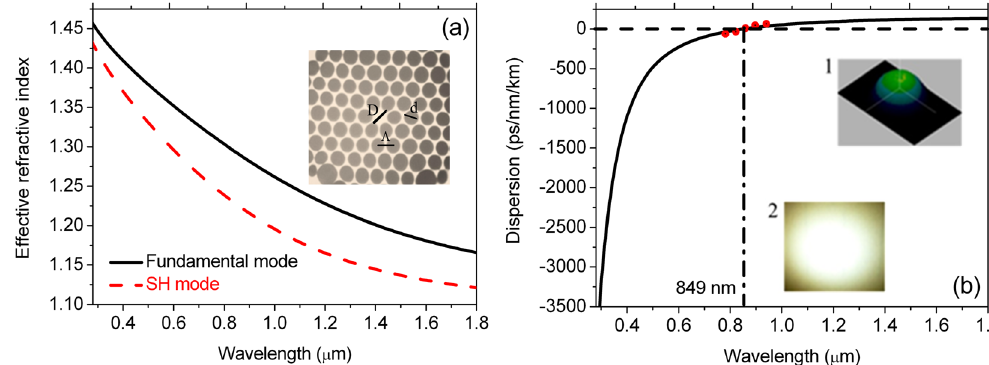
Figure 1. ( a ) The effective refractive index curves of the fundamental and SH modes calculated as functions of the wavelength. The inset shows the cross-sectional structure of the PCF used. ( b ) The calculated group-velocity dispersion profile of the fundamental mode with the zero-dispersion wavelength at 849 nm. The red solid dots correspond to the dispersion values measured by the pulse time-delay method. The insets 1 and 2 show the three-dimensional coupled-field profile observed at the input end of the PCF by a CCD camera and the output spatial far-field intensity distribution of the incident pump in the form of the fundamental mode,